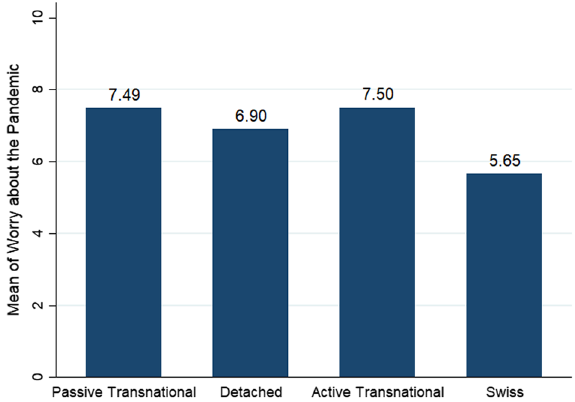
Fig. 3 Comparison of mean of worry about the pandemic between transnationalism